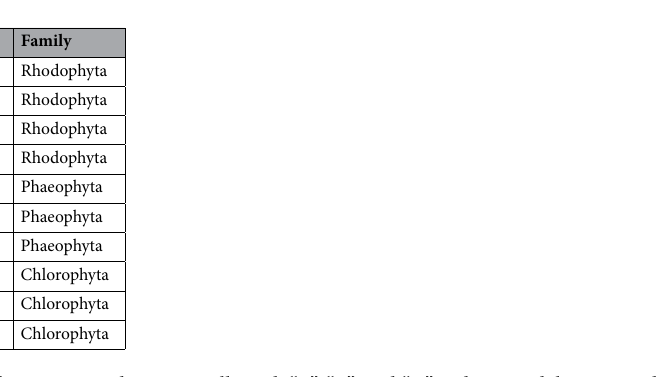
Table 1. Identity and labeling of the 10 seaweed species collected. “R”, “B”, and “G” indicate red, brown, and green seaweed respectively.